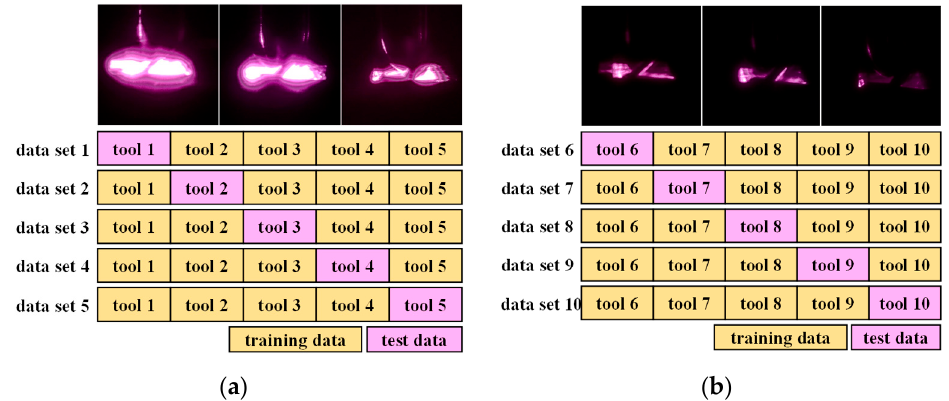
Figure 9. K-fold cross-validation method: ( a ) data without polarization filtering; ( b ) data with polarization filtering.